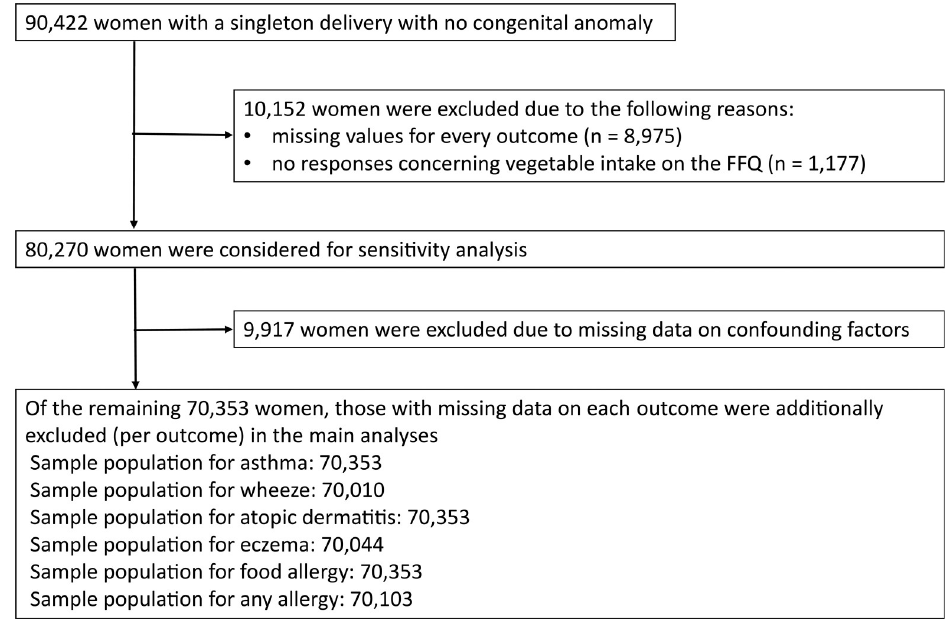
Fig 1. Flow chart showing the study population